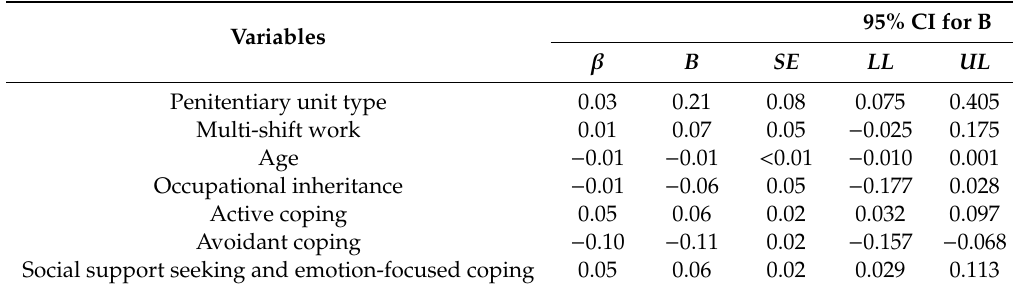
Table 3. Indirect e ff ects of subjective well-being in the explanatory model of work